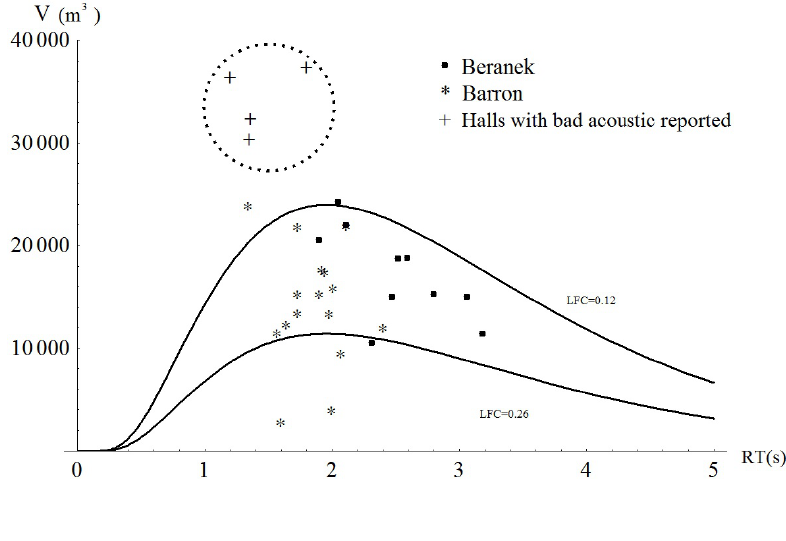
Figure 2. V-RT region following Ando-Beranek’s